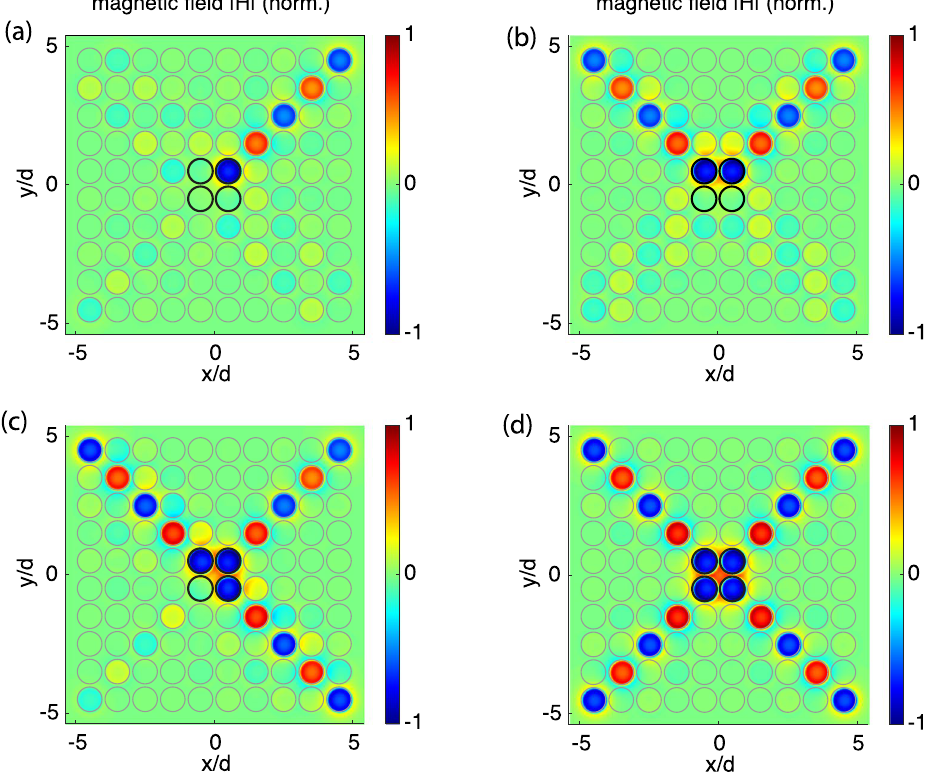
ω 0 . Magnetic field (normalised) = κ y 80 0.13 , Q = = = −